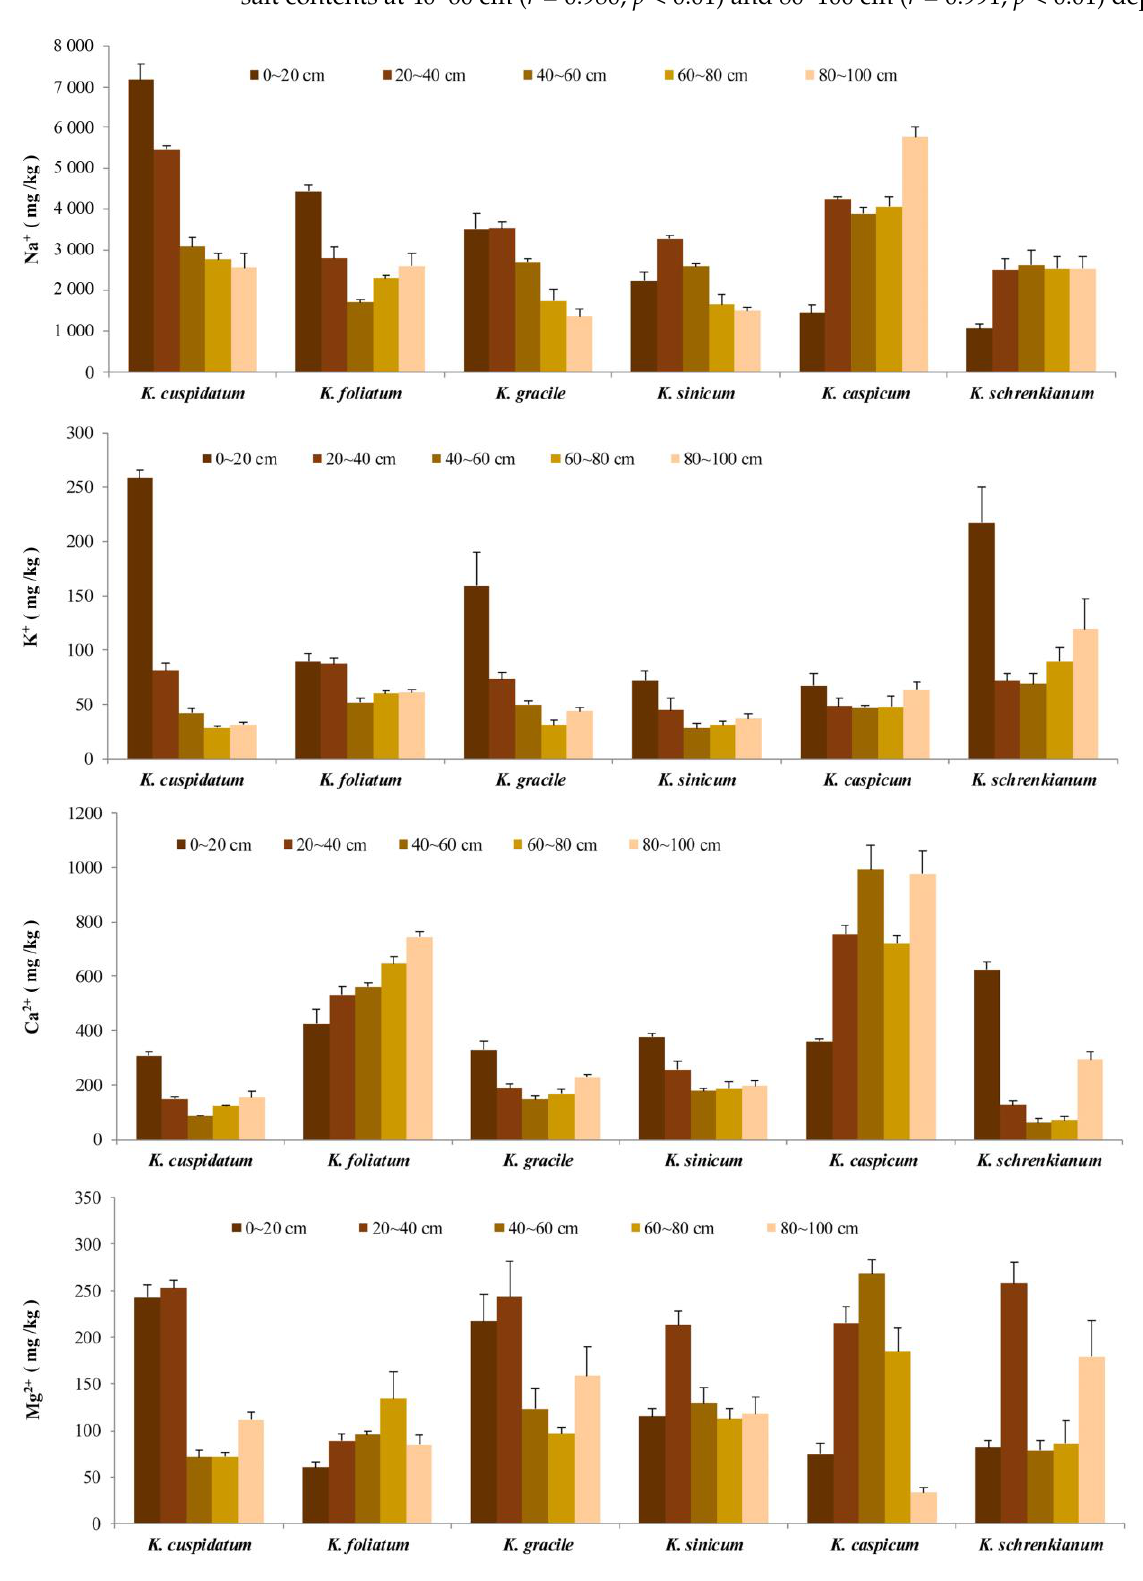
Figure 4. Concentrations of Na + , Ca 2+ , K + , and Mg 2+ in soil from indicated depths in areas occupied by the six Kalidium species. The values shown are means with SE ( n = 3).